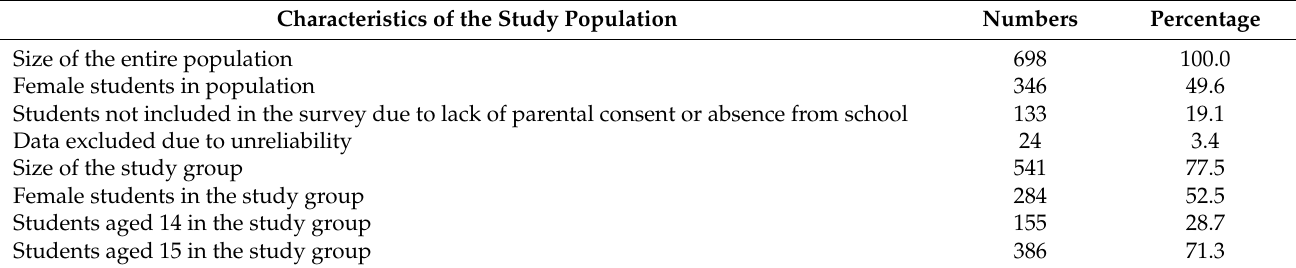
Table 1. Population and characteristics of the